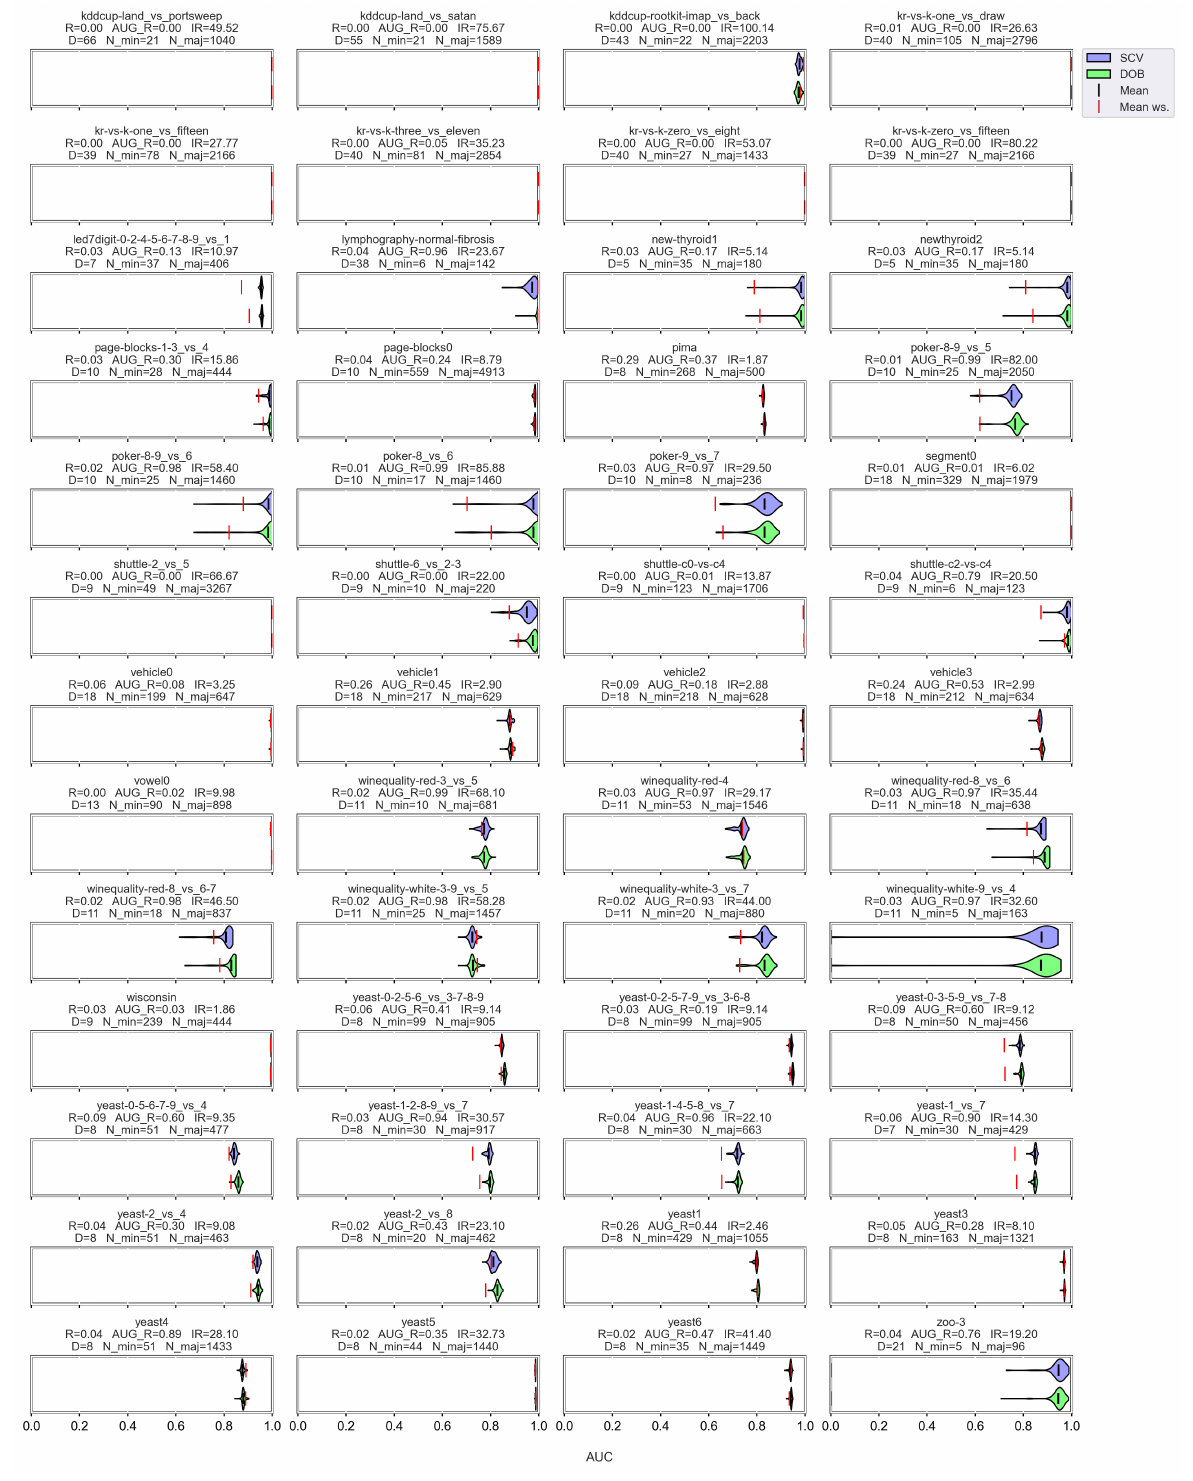
Figure A7. AUC values resulted by the MLP classifier and the named oversamplers per data set of